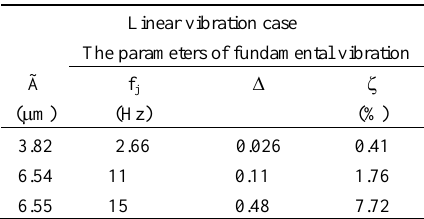
The vibration parameters − nonlinear